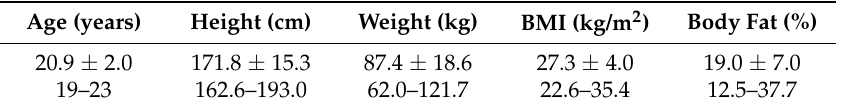
Table 1. Baseline characteristics of 18 male wrestlers 1